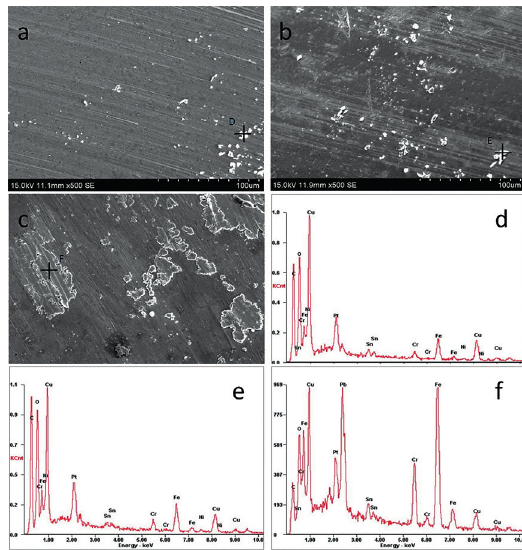
Figure 7: SEM images of the worn surface of counterparts of: (a) Ni containing graphite-CuSn10 composite layers with 10 vol% graphite, (b) no Ni containing graphite-CuSn10 composite layers with 10 vol% graphite, (c) CuSn10Pb10 alloy layers, (d) EDS pattern of point D in Fig. 7a, (e) EDS pattern of point E in Fig. 7b, (f) EDS pattern of point F in Fig. 7c